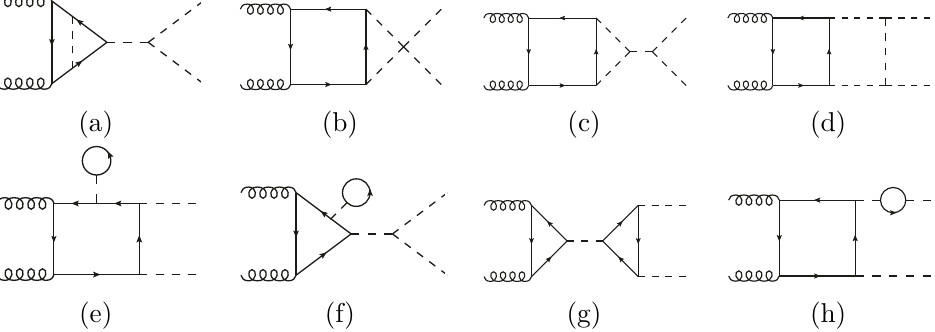
Figure 2 . Diagrams with Higgs boson self coupling and one-particle reducible diagrams. These classes of diagrams are not considered in this